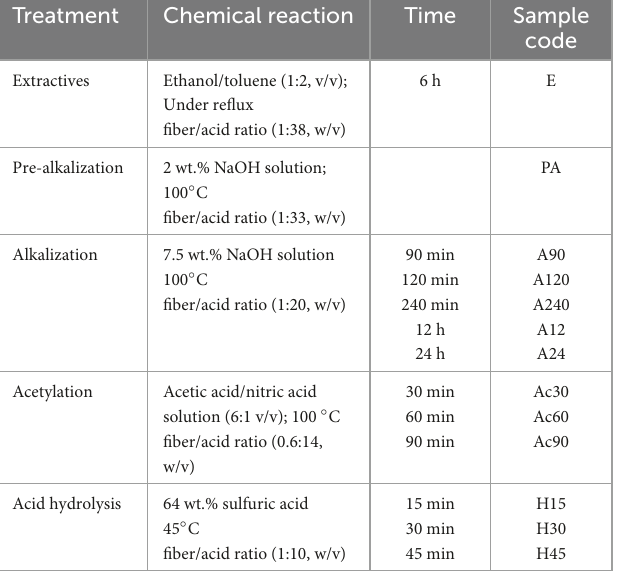
TABLE 2 Box–Behnken experimental design and crystallinity index (CI) code